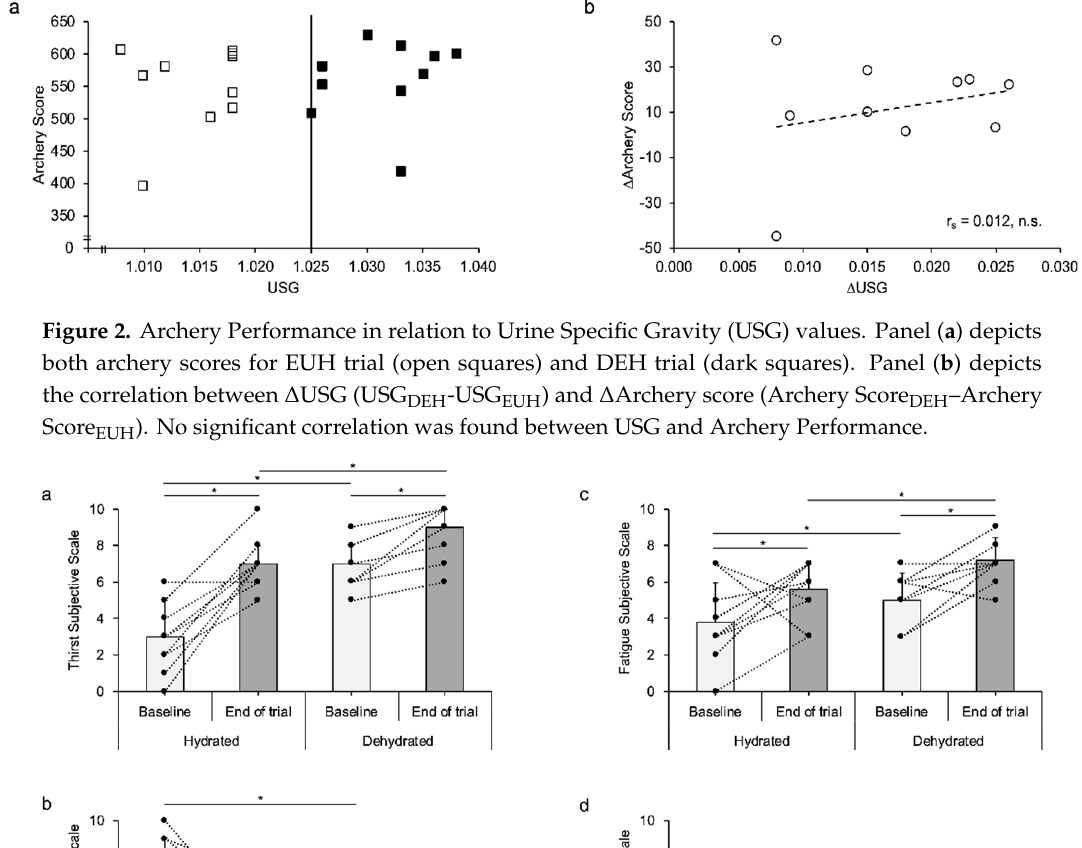
Figure 4. Heart rate response to hydration (open circles) and dehydration (dark squares) state, during the archery competition simulation. * Indicates difference between trials ( p < 0.050). During exercise, heart rate was higher than baseline in both trials. 4. Discussion In the current study, it was shown that dehydration induced psychological and physiological strain but did not alter shooting performance of national level archers during a competition simulation in hot environment. Specifically, the results of the current study indicate that archery score was not affected by dehydration. Nevertheless, significant differences on HR, subjective feelings of fatigue, and concentration were observed between conditions. Α compelling amount of evidence suggests that overall fitness, core strength, handgrip, upper body strength and static balance are related to archery performance and high scores [22,23]. In the present study, archery performance was similar between dehydration and euhydration trials; thereby, any potential effect on muscle function was not observed. Previous studies demonstrated that dehydration may decrease upper body muscle power during a maximum intensity anaerobic test [24] and during a fatiguing isometric strength protocol of repeated efforts at 85% of maximum